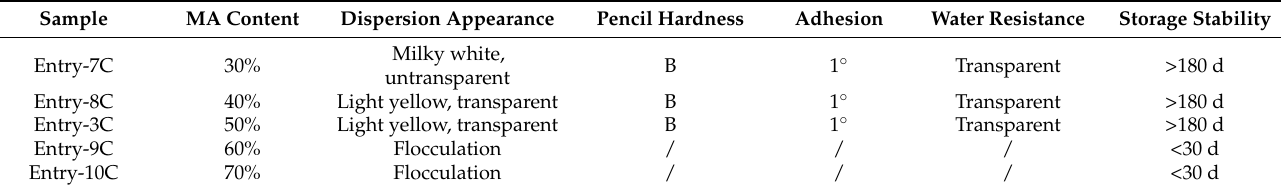
Table 3. The properties of NWCPE dispersions and cured films with different MA